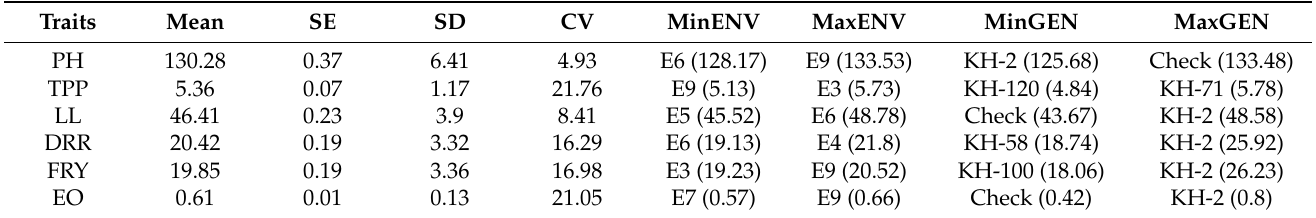
Table 1. Mean and range for all the studied traits of six high-yielding genotypes of C. caesia in MLT.